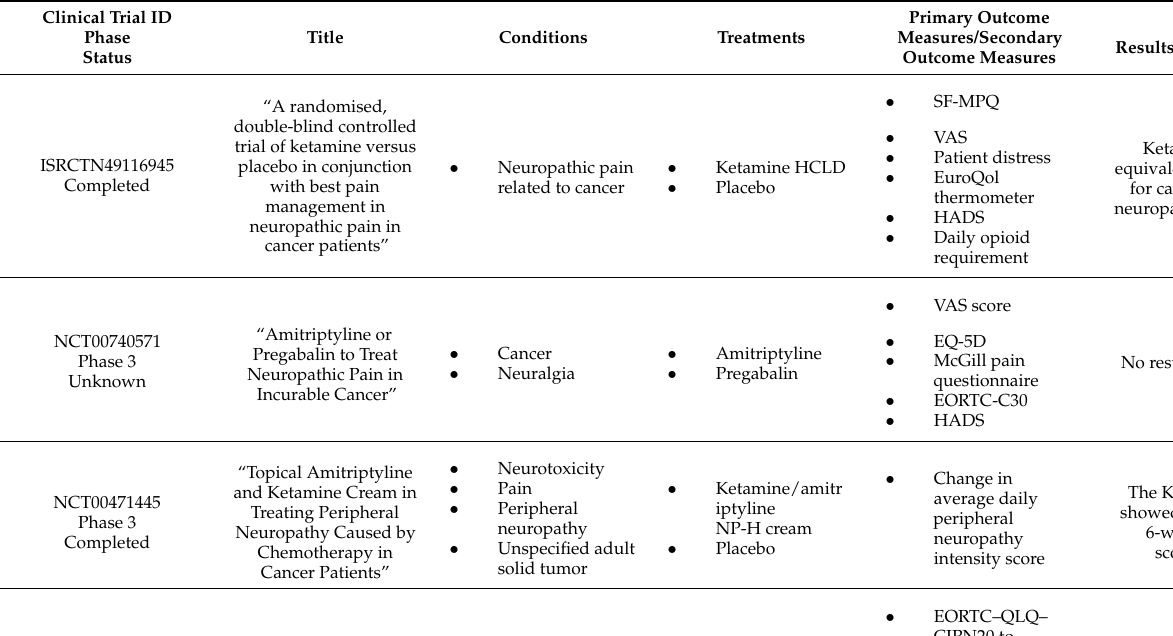
Table 1. Clinical trials with TCAs to treat neuropathic pain in oncology